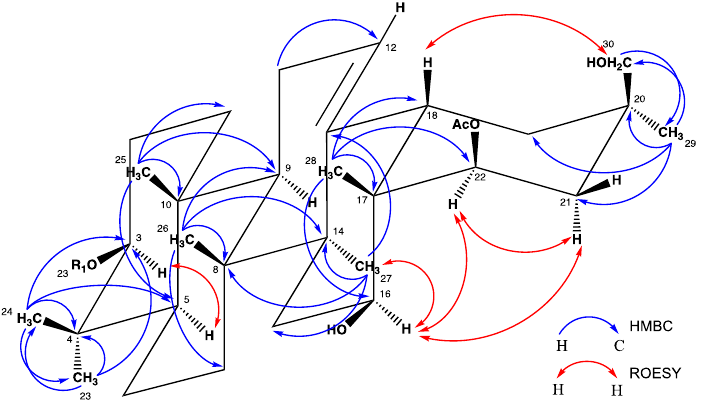
Figure 2. Key HMBC and ROESY correlations for the aglycone of 1.